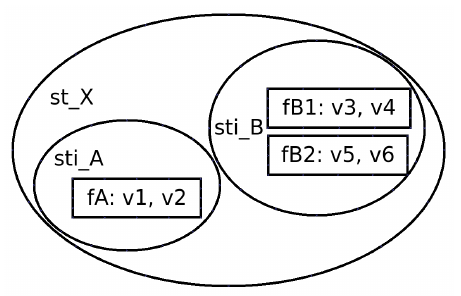
Figure 13: An example speciesFeatureType to illustrate the usage of ListOfSpeciesFeatures , SubListOfSpecies- Features and the SpeciesFeature